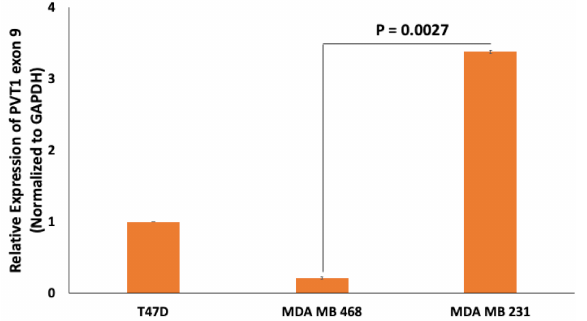
Figure 3. Comparison of PVT1 exon 9 expression in the T47D estrogen receptor positive BC cell line, MDA MB 468 CH TNBC cell line and the MDA MB 231 cell CL TNBC cell line. PVT1 exon 9 expression was assessed using RT-qPCR in the T47D estrogen receptor positive BC cell line, MDA MB 231 CL TNBC cell line and in the MDA MB 468 CH TNBC cell line. Expression was normalized against GAPDH. Data presented are from experiments performed in quadruplicates 6 separate times.